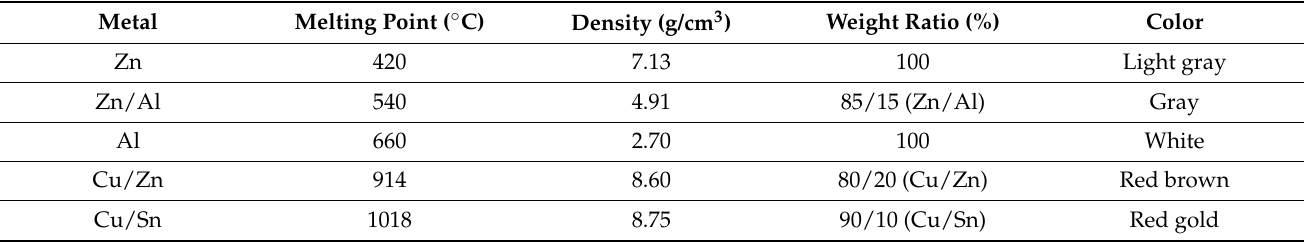
Table 2. Properties of metals used in